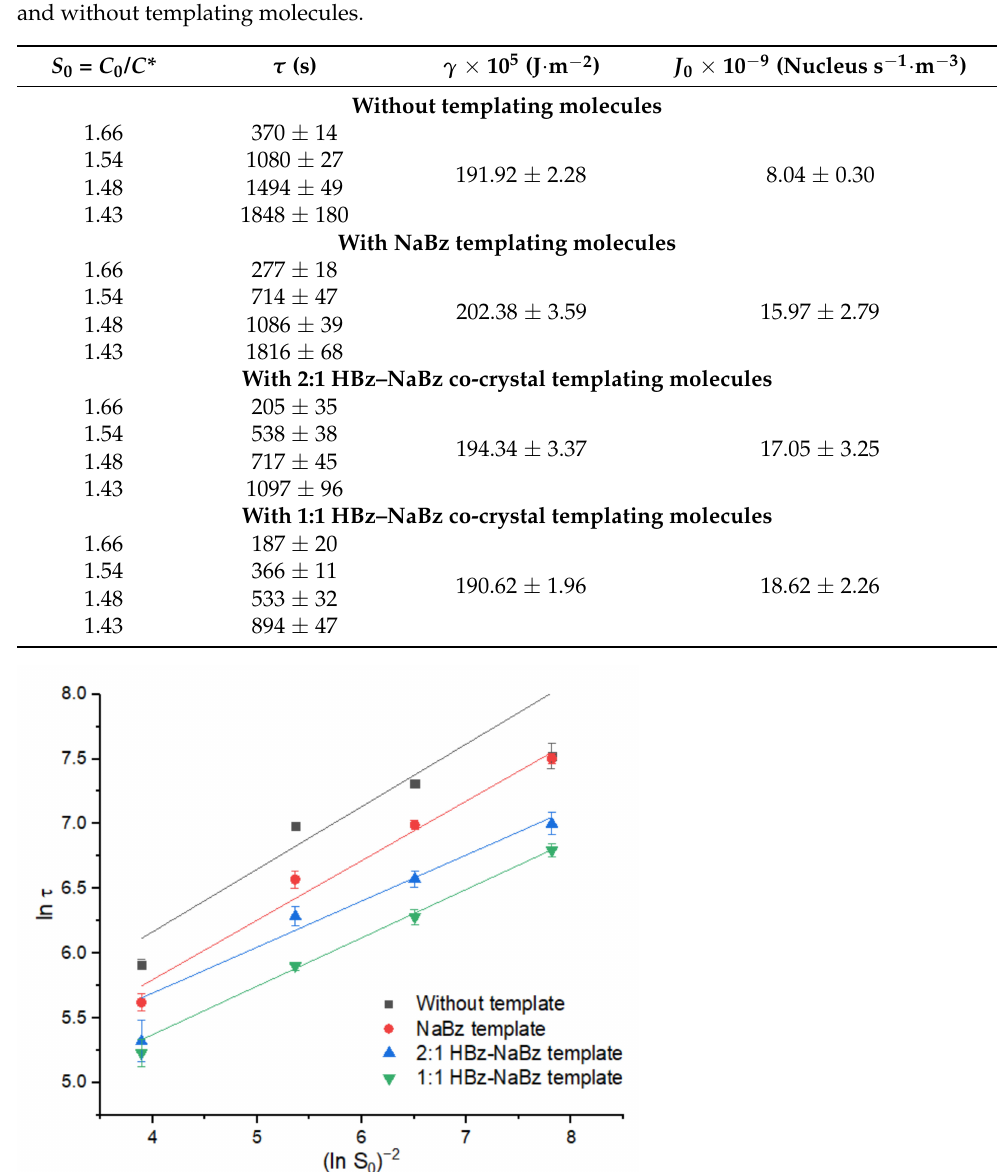
Table 1. Induction period ( τ ), interfacial energy ( γ ), and nucleation rate pre-exponential factor ( J 0 ) of co-crystallization of 2:1 HBz–NaBz co-crystals at different initial degrees of supersaturation ( S 0 ) with and without templating molecules.